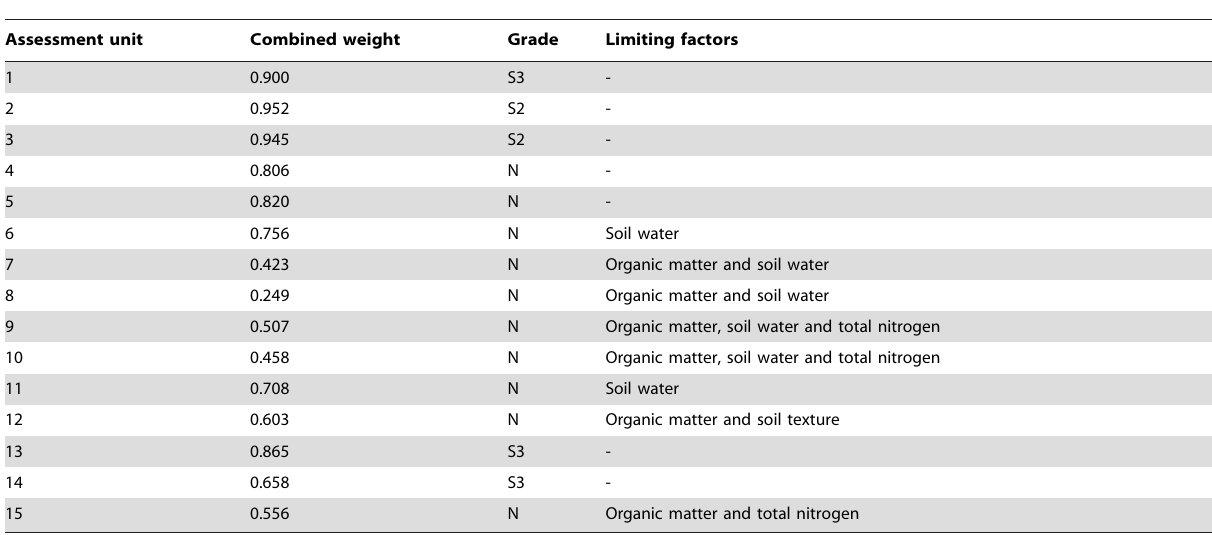
Table 11. Forestland suitability and limiting factors for each assessment unit.